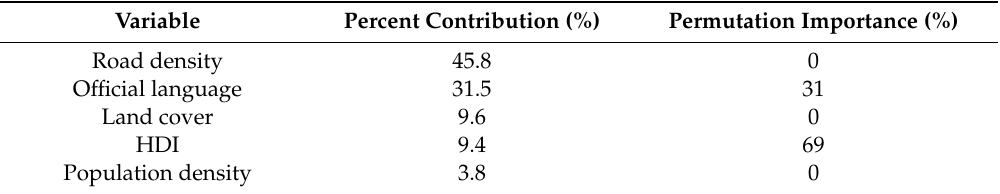
Table 2. Relative contributions of the environmental and cultural variables to the Maxent